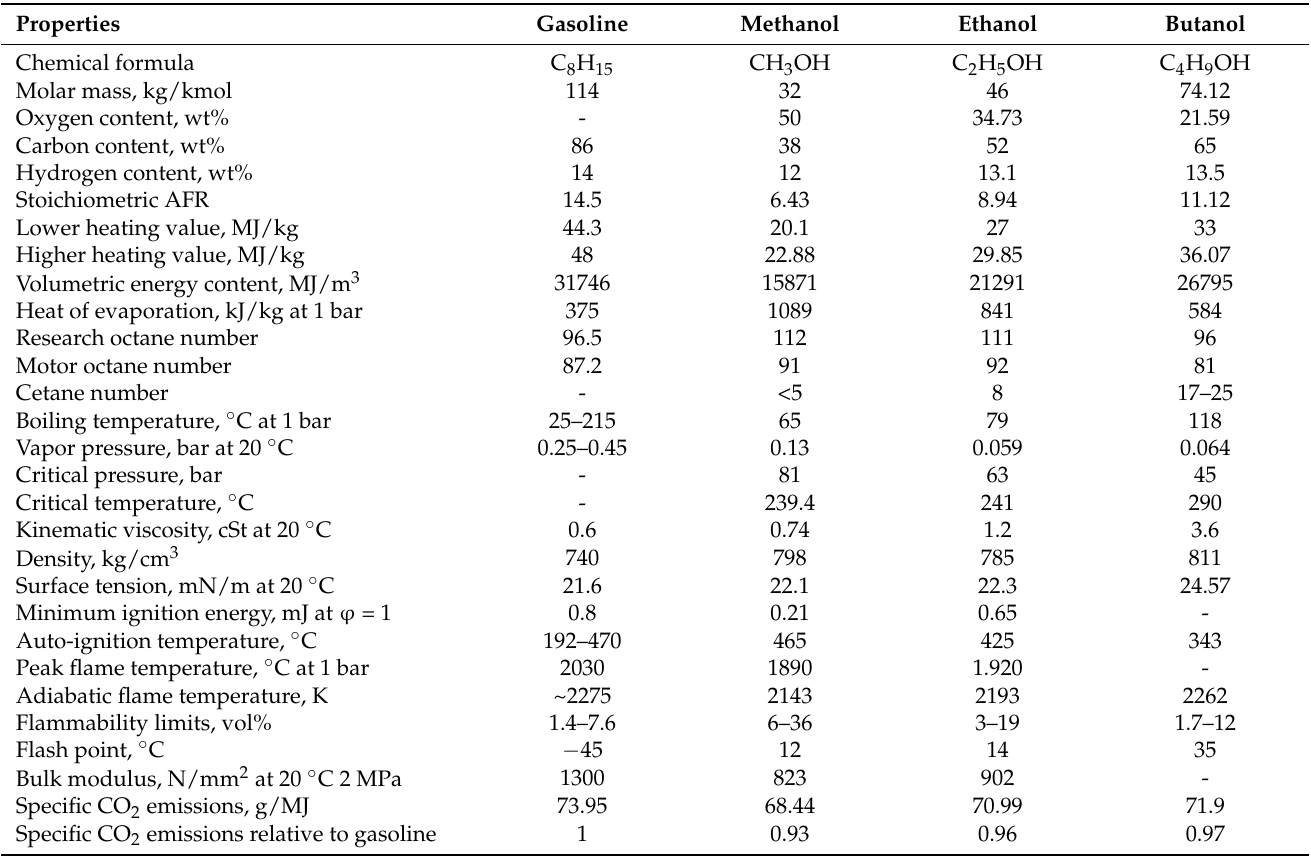
Table 1. Comparison of fuel properties of gasoline, methanol, ethanol, and butanol